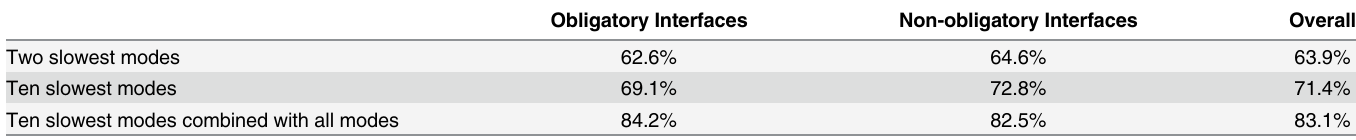
Table 1. The success rate of DynaFace.